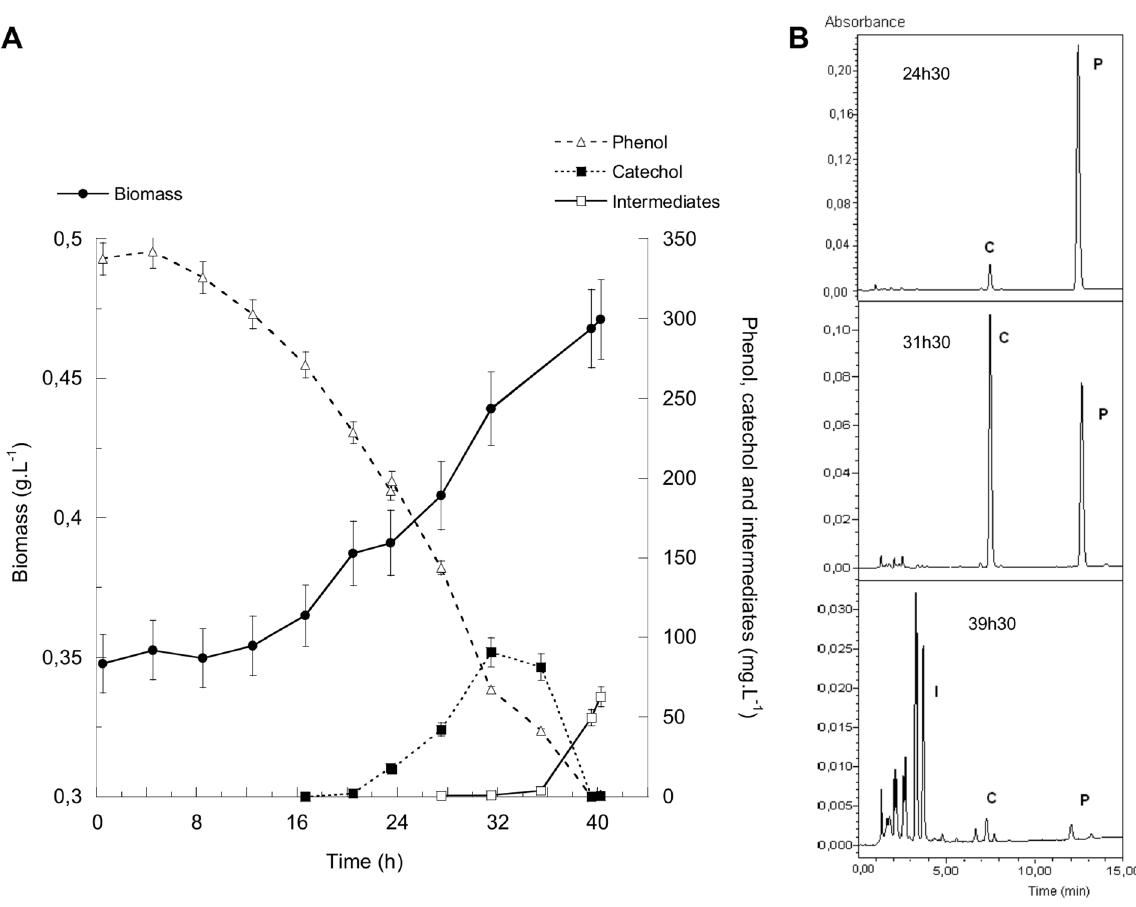
Figure 1. Analysis of S.solfataricus 98/2 cultures grown on phenol at a DOC of 0.06 mg.L 2 1 . (A) biomass, catechol and other intermediate productions and phenol consumption. The intermediate curve corresponds to the sum of all the detected compounds. (B) HPLC chromatograms ( l = 270 nm) obtained at three different time course of the run (P: phenol, C: catechol, I: intermediates).